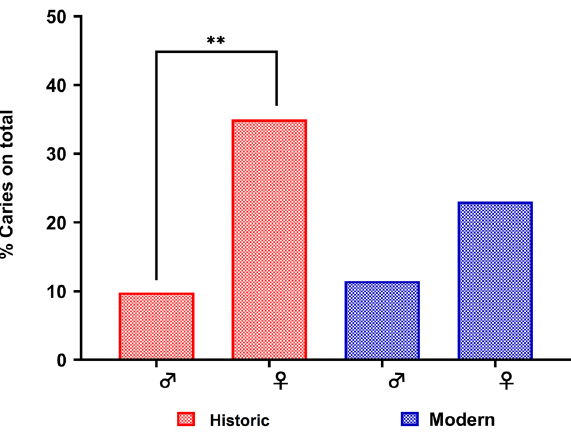
Figure 3. Sex differences in dental caries % evaluated in ancient and modern teeth. Total historical teeth n = 51: historical male teeth n = 23; historical female teeth n = 28; total modern teeth n = 26: modern male teeth n = 12; modern female teeth n = 14 ( p < 0.05).